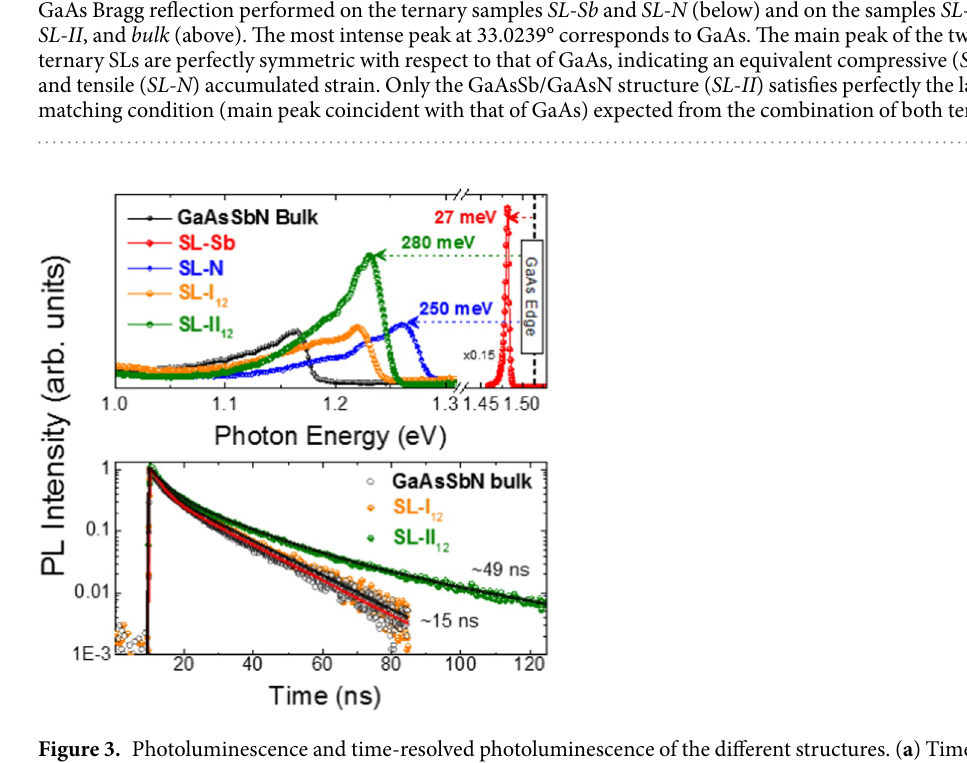
redshifts from the nominal bandgap value. Finite differences calculations shown below suggest that quantum confinement size effect in the 12 nm period SLs is only ~39 meV, what would only partially explain the PL peak difference of 55 meV as compared to the bulk. The redshift of the PL peak energy and the tensile position of the HR-XRD central peak shown in Fig. 2 rather points to an unwanted incorporation of N in this sample (and, to a lesser extent, also in the SL-I sample), which was suppressed in the SL - II sample using alternate deposition of the ternary compounds. Time resolved-photoluminescence (TR-PL) decay curves measured at the PL peak energy provide further details about the carrier confinement within each sample. As shown in Fig. 3b, SL-I and bulk samples have similar decay dynamics, clearly different from those of sample SL-II . A multi-exponential fitting analysis is necessary to describe the decay dynamics across the full-time range and can be found as Supplementary Table S1. Yet, the larger differences occur for long times after the excitation where the decay of the luminescence of sample